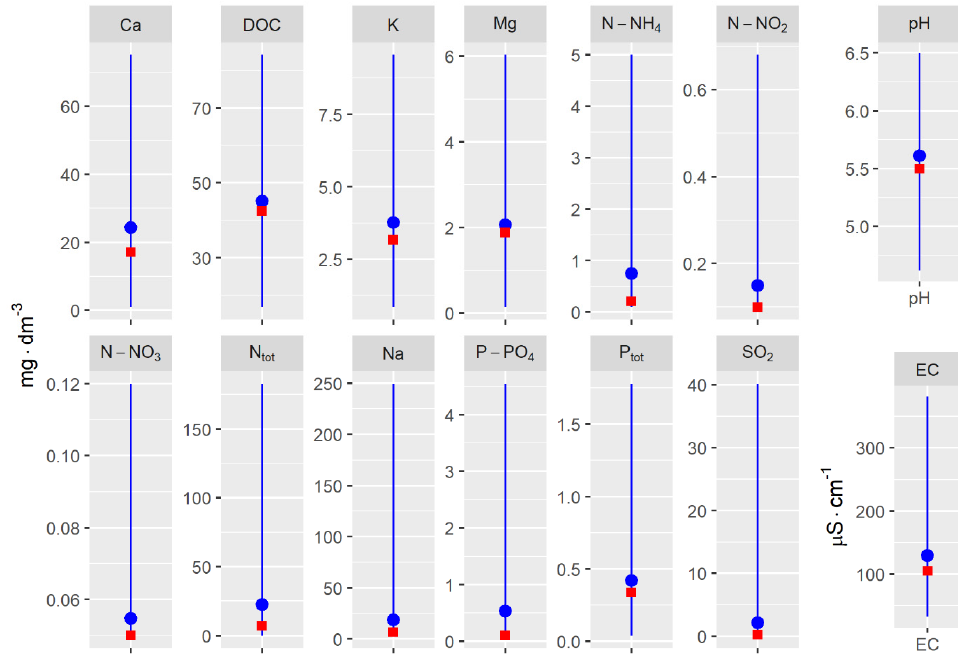
Figure 2. Distribution of values of physicochemical factors of piezometric groundwater at the study sites in 2011–2013. The blue line, blue dot, and red square represent the range of values, mean value, and median, respectively.